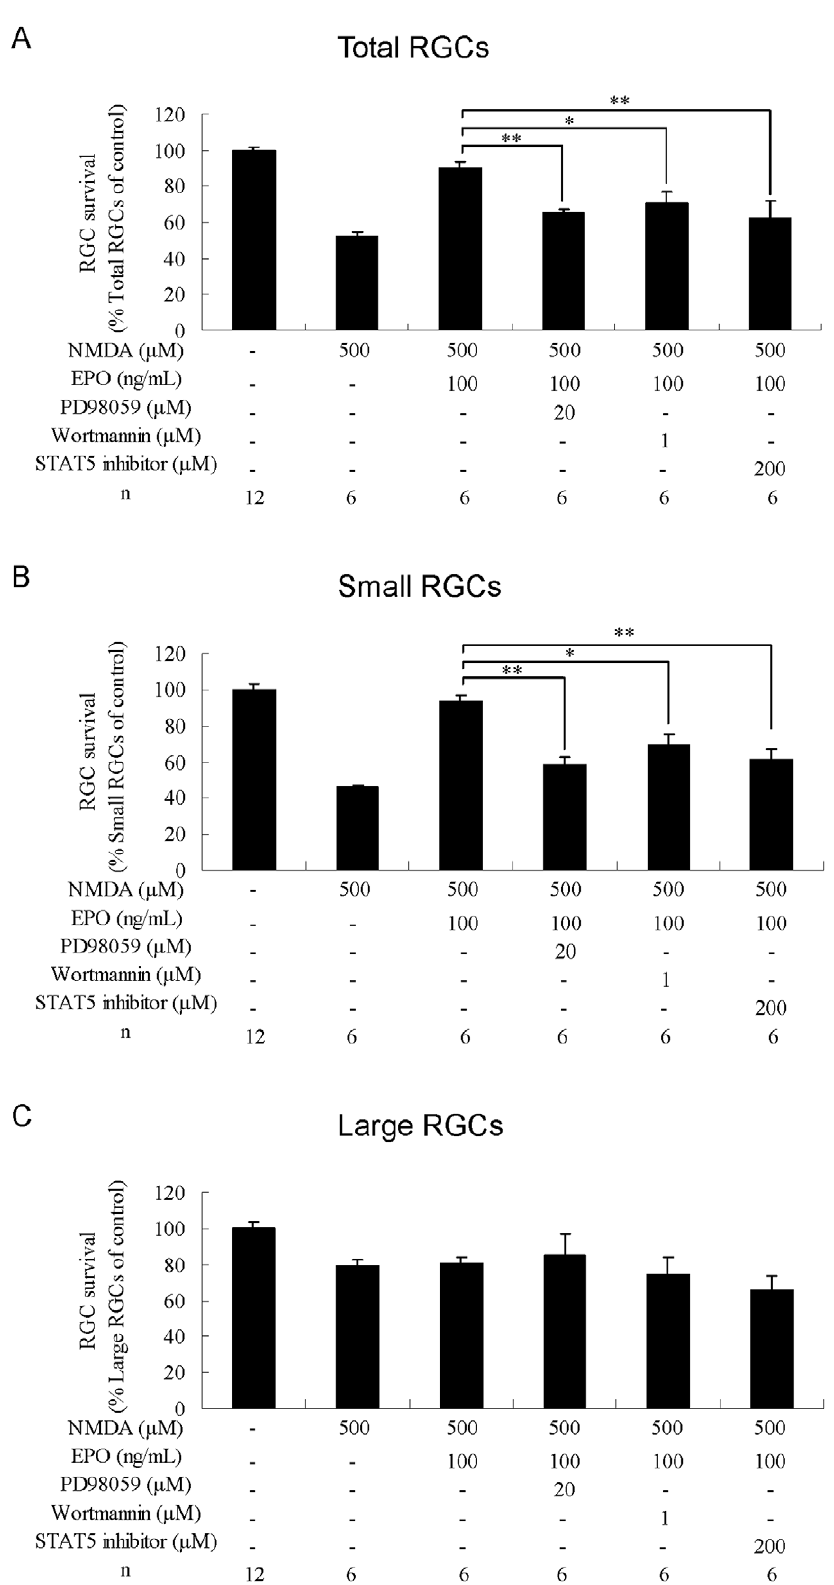
Figure 5. Effects of combined treatment with erythropoietin and kinase inhibitors on RGCs under NMDA-induced toxicity. Survival rates of (A) total, (B) small, and (C) large RGCs were estimated as percentages of the control. Data are presented as mean 6 standard error of the mean (n=6–12). Data were statistically analyzed by 1-way ANOVA, followed by Dunnett’s test. *P , 0.05, **P , 0.01 and ***P , 0.001.